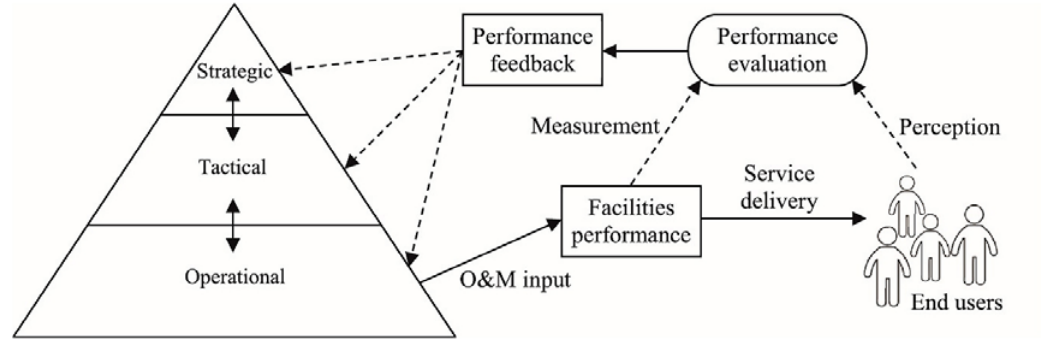
Fig. 2. Information and resources flows in facilities services